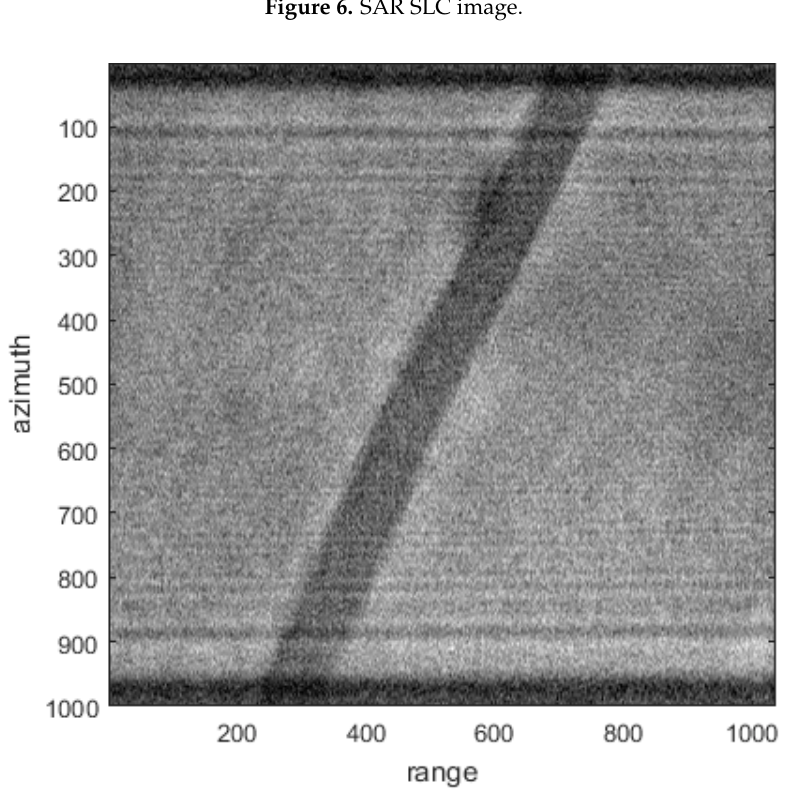
Figure 7. SAR simulated raw data of the scene without moving targets.